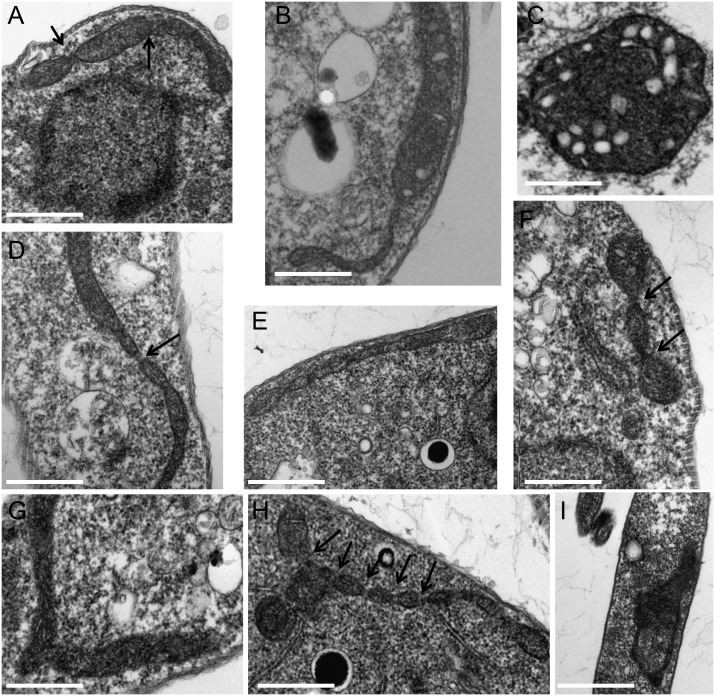
Transmission electron microscopy (TEM) analysis of PCF TbDLP RNAi, TbDLP1 and TbDLP2 rescue cell lines.A)-C): TbDLP RNAi cell line, induced for 2 (A), 3 (B) and 4 (C) days, D)-F): TbDLP1 rescue cell line, induced for 2 (D), 3 (E) and 4 (F) days, G)-I): TbDLP2 rescue, induced for 2 (G), 3 (H) and 4 (I) days. Scale bar = 500nm, arrows point to mitochondrial constrictions observed in all three cell lines.